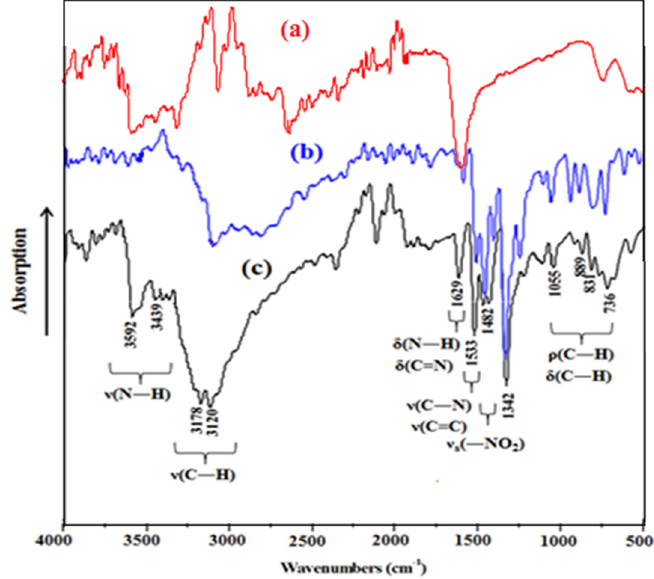
Figure 8. ( a ) IR spectra of ZnCl 2 ; ( b ) IR spectra of 5-nitrobenzimidazole; ( c ) IR spectra of (C 7 H 6 N 3 O 2 ) 2 [ZnCl 4 ].